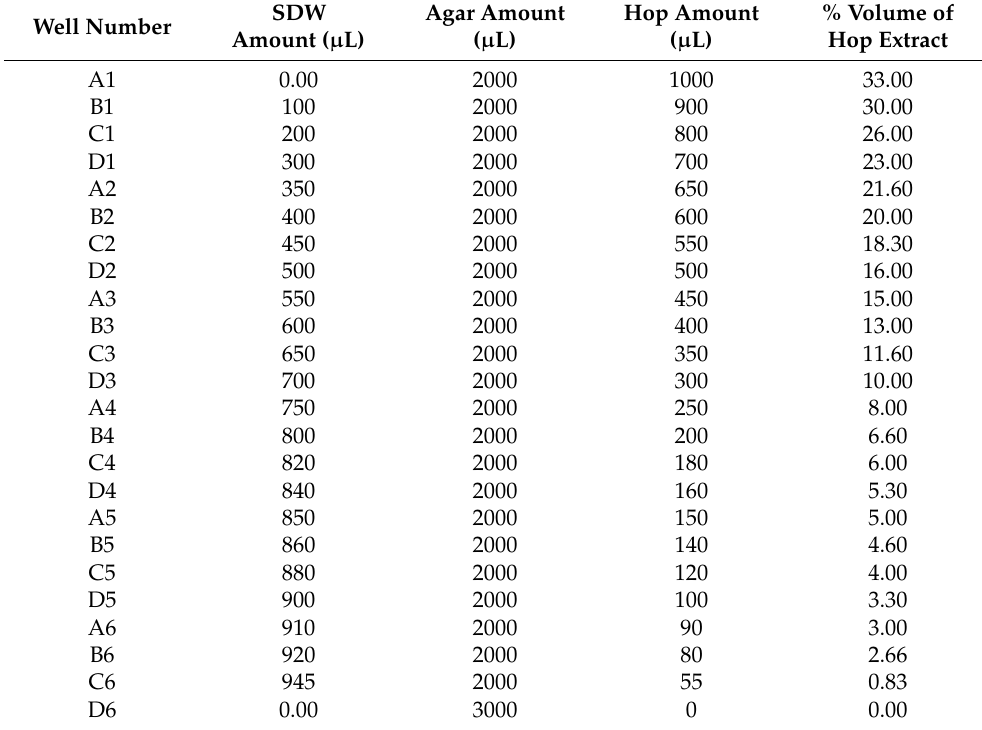
Table 2. The volumes of double concentrated agar, SDW and aqueous hop extract used to generate a range of hop concentrations between 0 and 33% ( v / v ) within the agar incorporation assay.